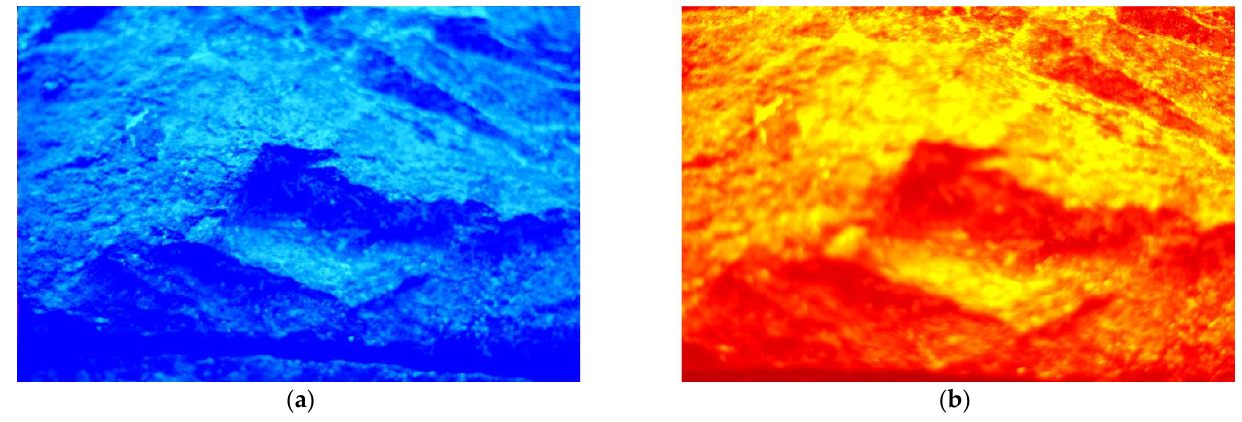
Figure 9. The first ( a ) and the fifteenth ( b ) image of a series of fifteen images of blue marble (see Figure 3) displayed in supplementary pseudo-colours. The software used has been written by the author. Taken from [26].